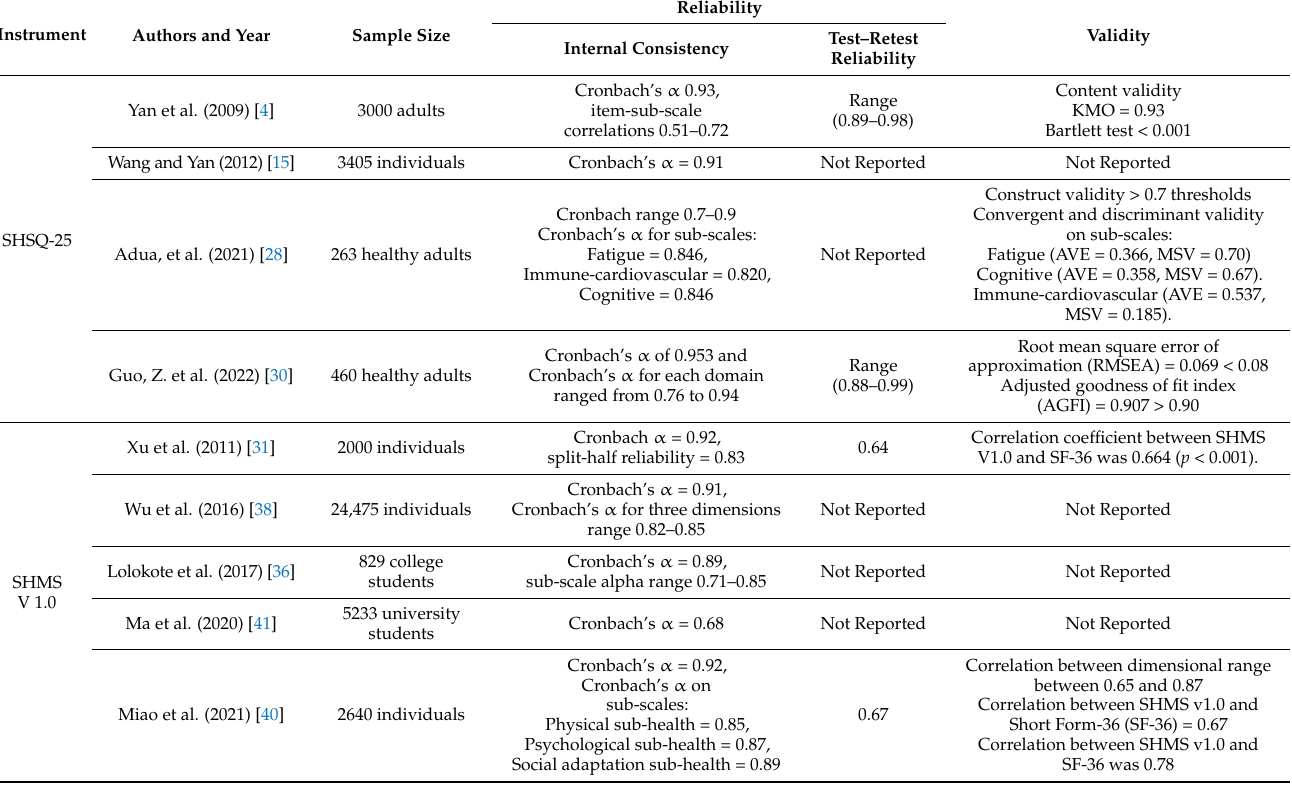
Table 2. Studies on reliability and validity of SHSQ-25 and SHMS V 1.0